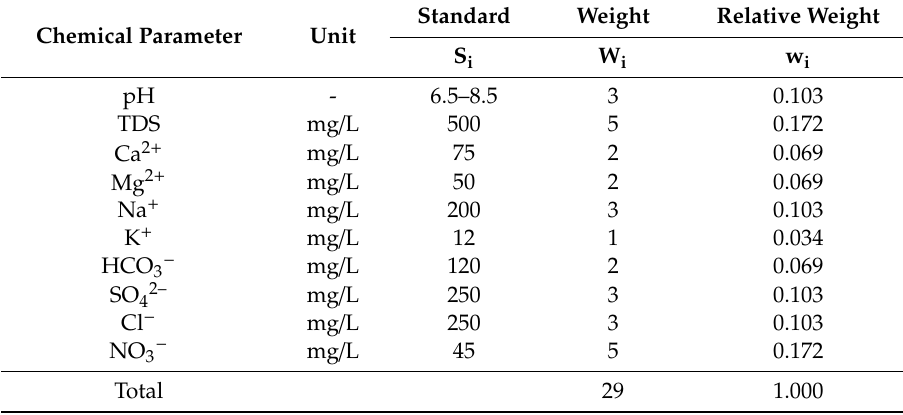
Table 1. List of physico-chemical parameters with corresponding unit, WHO standard ( S i ), WQI weight ( W i ), and normalized weight ( w i